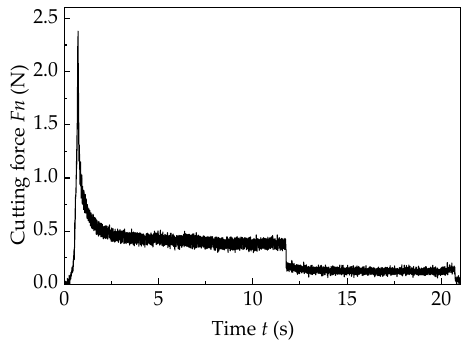
Figure 6. The measured force curve.